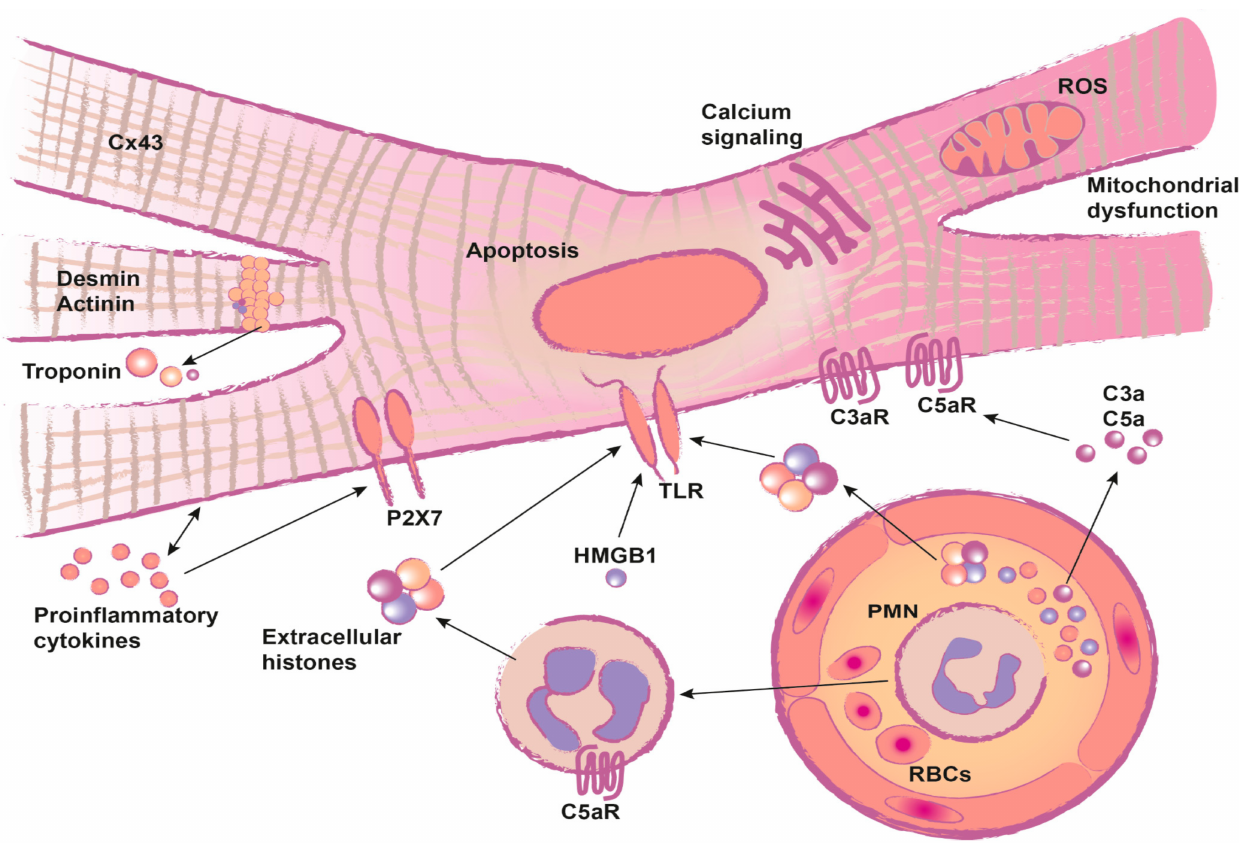
Figure 1. Molecular mechanism of post-traumatic cardiac